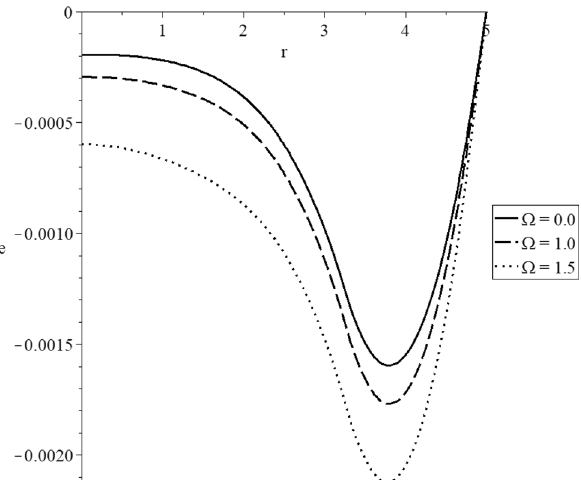
Figure 17. The volumetric deformation distribution with various values of the angular velocity of the rotation parameter.